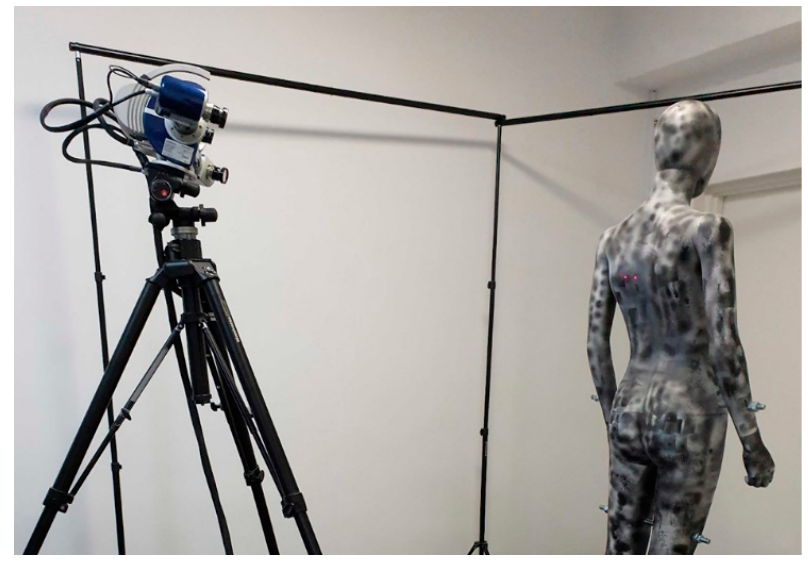
Figure 8. Determination of the reference model using the Hexagon Stereo Scan scanner (AICON).